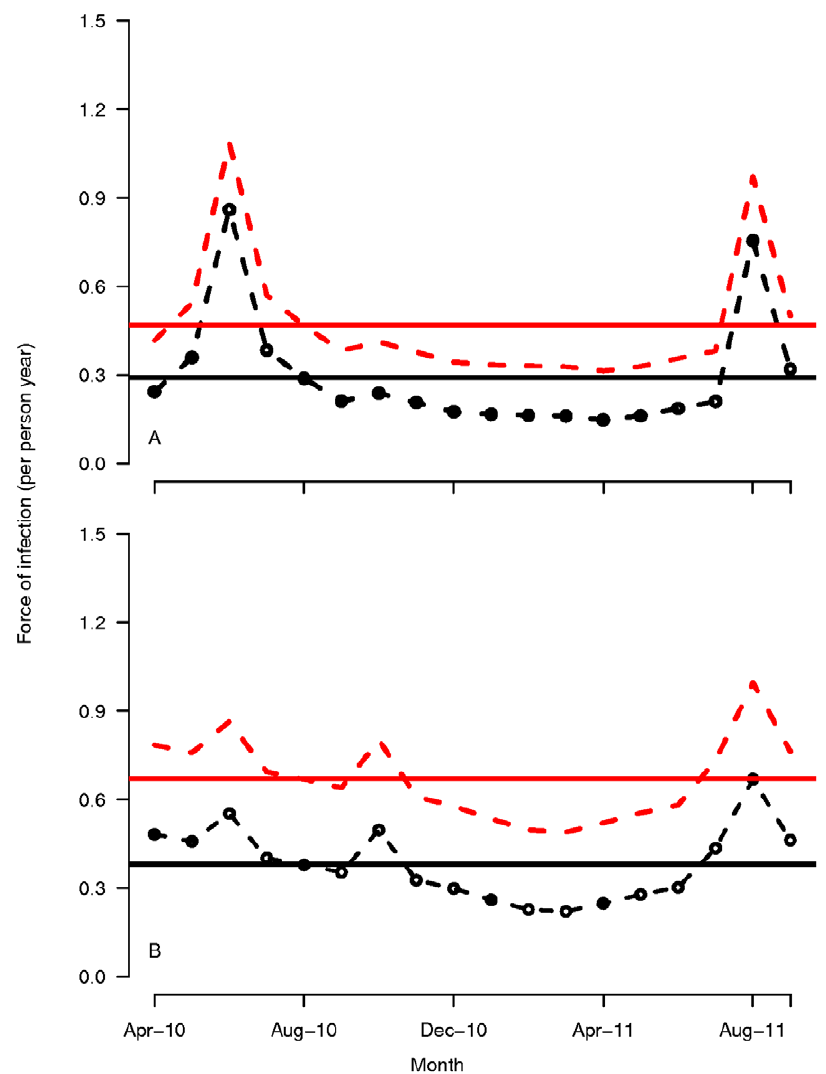
Figure 4. Monthly and average force of infection estimates for Bulbulla and Asendabo health center catchment areas in Ethiopia. Monthly (dashed lines) and annual average force of infection ( l 0 : new infections prior to any treatment per person month) estimates assuming perfect detectability (black lines) or 50% detectability (red lines) in A Bulbulla and B Asendabo health center catchment areas.